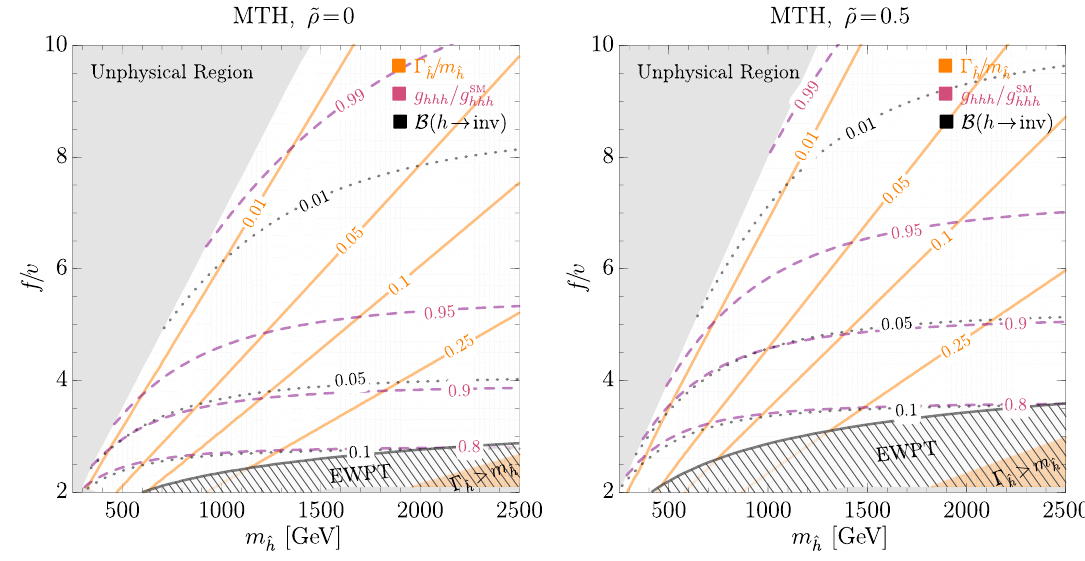
Figure 7 . These plots show parameter space in m ^ and ~ (cid:26) = 0 : 5 (right). The contours of the ratio of heavy twin Higgs width over its mass (cid:0) ^ orange), the ratio of the SM-like Higgs trilinear coupling over its corresponding SM values g hhh =g sm (dashed purple), and the SM Higgs invisible (twin) branching fraction B ( h ! inv : ) (dotted). The gray area corresponds to the unphysical parameters, the hatched-gray region is excluded by the EWPT at 95% C.L., and the orange region represents (cid:0) ^